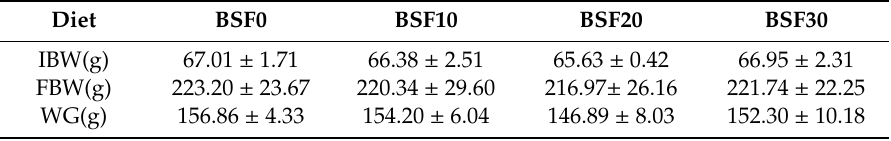
Table 7. Growth performances of rainbow trout fed the experimental diets (n = 3 tanks).